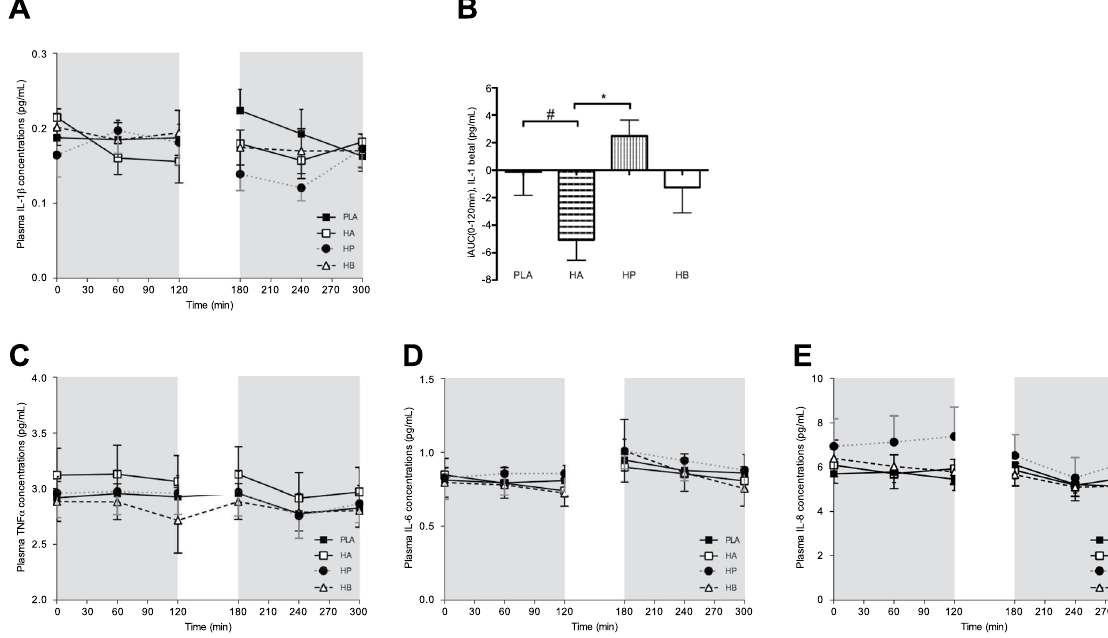
Figure 5. Effect of colonic administration of SCFA mixtures on fasting and postprandial plasma inflammatory cytokines ( A ) Fasting (t0–t120 min) and postprandial (t180–t300 min) plasma IL-1 β concentrations after colonic SCFA infusions. ( B ) iAUC for fasting (t0–t120 min) plasma IL-1 β following colonic SCFA infusion. Values are means ± SEMs (n = 10, for two volunteers IL-1 β concentrations were not detectable). Overall treatment effect for fasting IL-1 β P = 0.068 (period P = 0.626, carry-over P = 0.841). ( C ) Fasting (t0–t120 min) and postprandial (t180–t300 min) plasma TNF- α after colonic SCFA infusions. Values are means ± SEMs (n = 12).) ( D ) Fasting (t0–t120 min) and postprandial (t180–t300 min) plasma IL-6 after colonic SCFA infusions. Values are means ± SEMs (n = 11, for one participant IL-6 concentrations were not detectable). ( E ) Fasting (t0–t120 min) and postprandial (t180–t300 min) plasma IL-8 after colonic SCFA infusions. Values are means ± SEMs (n = 12). Statistical significance indicated as asterisk ( * ) when * P < 0.05 and as hashtag